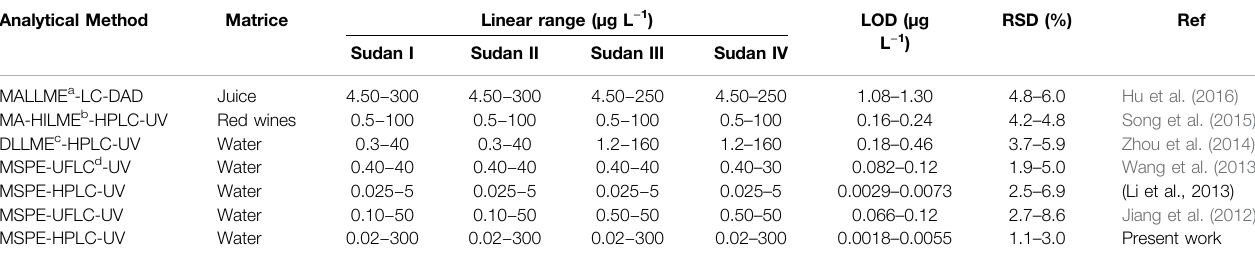
TABLE 3 | Comparison with reported methods for the determination of Sudan dyes. Analytical